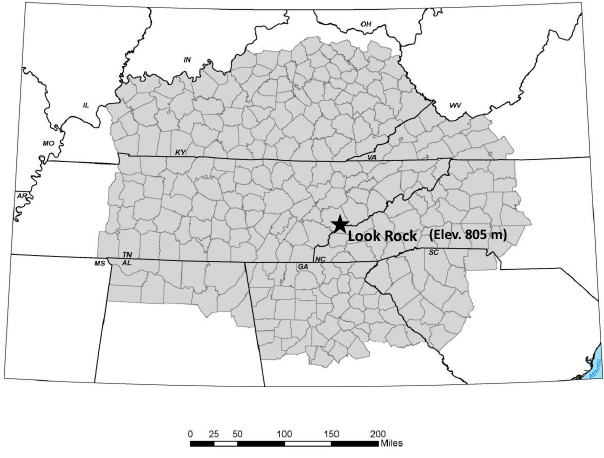
Figure 1. Spatial domain used to compare trends in air quality with trends in emissions of precursor species.